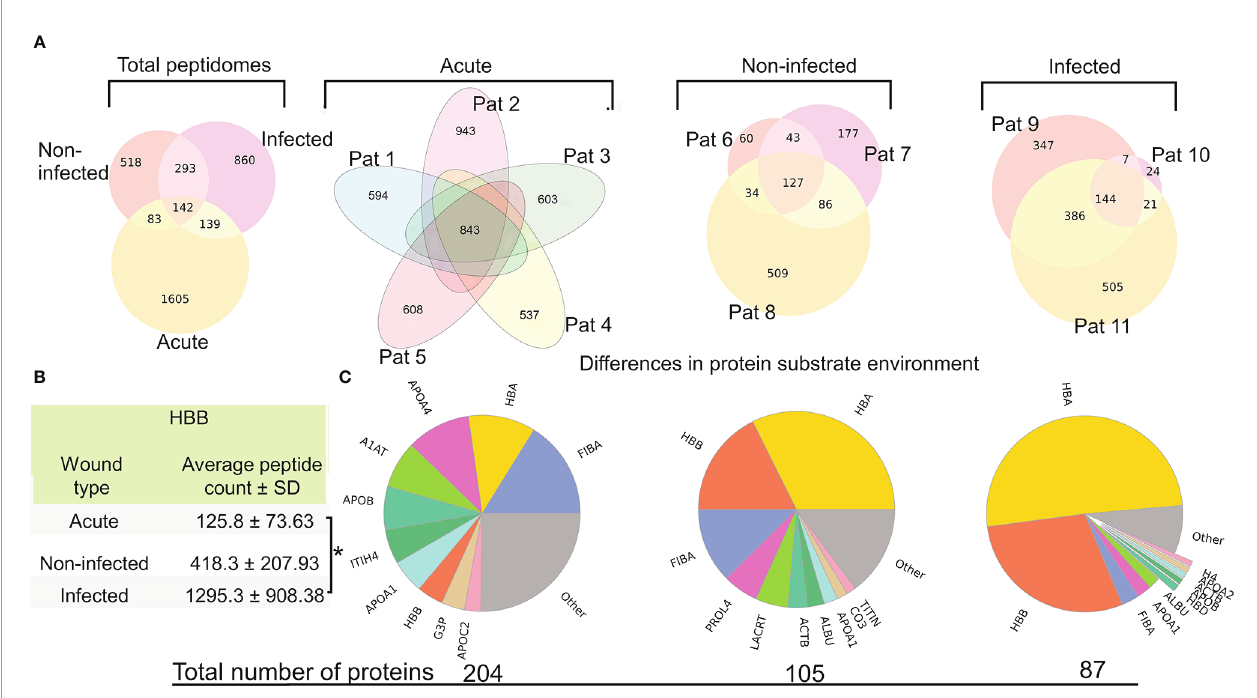
FIGURE 2 | Large intra and inter group peptide variance and differences in protein substrate distribution (A) Venn-diagrams depicting the intra and inter group variance of peptide sequences, after employing a spectral count cut off. The leftmost diagram shows the intergroup variance, whereas the other depict the intragroup peptidomic variances. (B) Table showing the average amount of peptides derived from hemoglobin subunit beta (HBB) in the groups, showing signi fi cantly more peptides derived from HBB in the infected group as compared to the acute wound fl uid group (p=0.0231) (C) Pie charts of the protein substrate environment in the different groups made by counting the total spectral count of all peptides associated to its parent protein. The numbers below the pie charts are the total number of proteins that have one or more